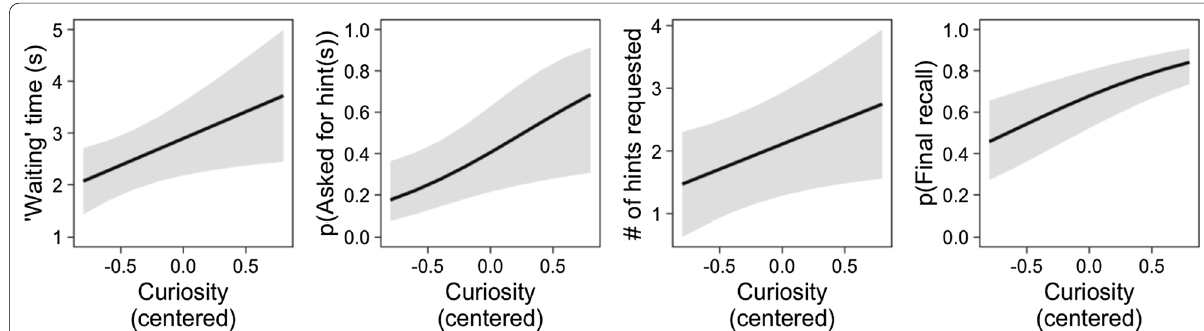
Fig. 1 Wait times, hint seeking, and final recall as a function of curiosity, from Experiment 1. Note. Far Left: Time ‘waiting’ before requesting the answer as a function of curiosity. Left Center: Probability of asking for one or more hints as a function of curiosity. Right Center: Average number of letters (hints) viewed as a function of curiosity. Far Right: Probability of correct recall at posttest as a function of curiosity. The lines and shade represent the average relation with a 95%CI, from the mixed‑effects model